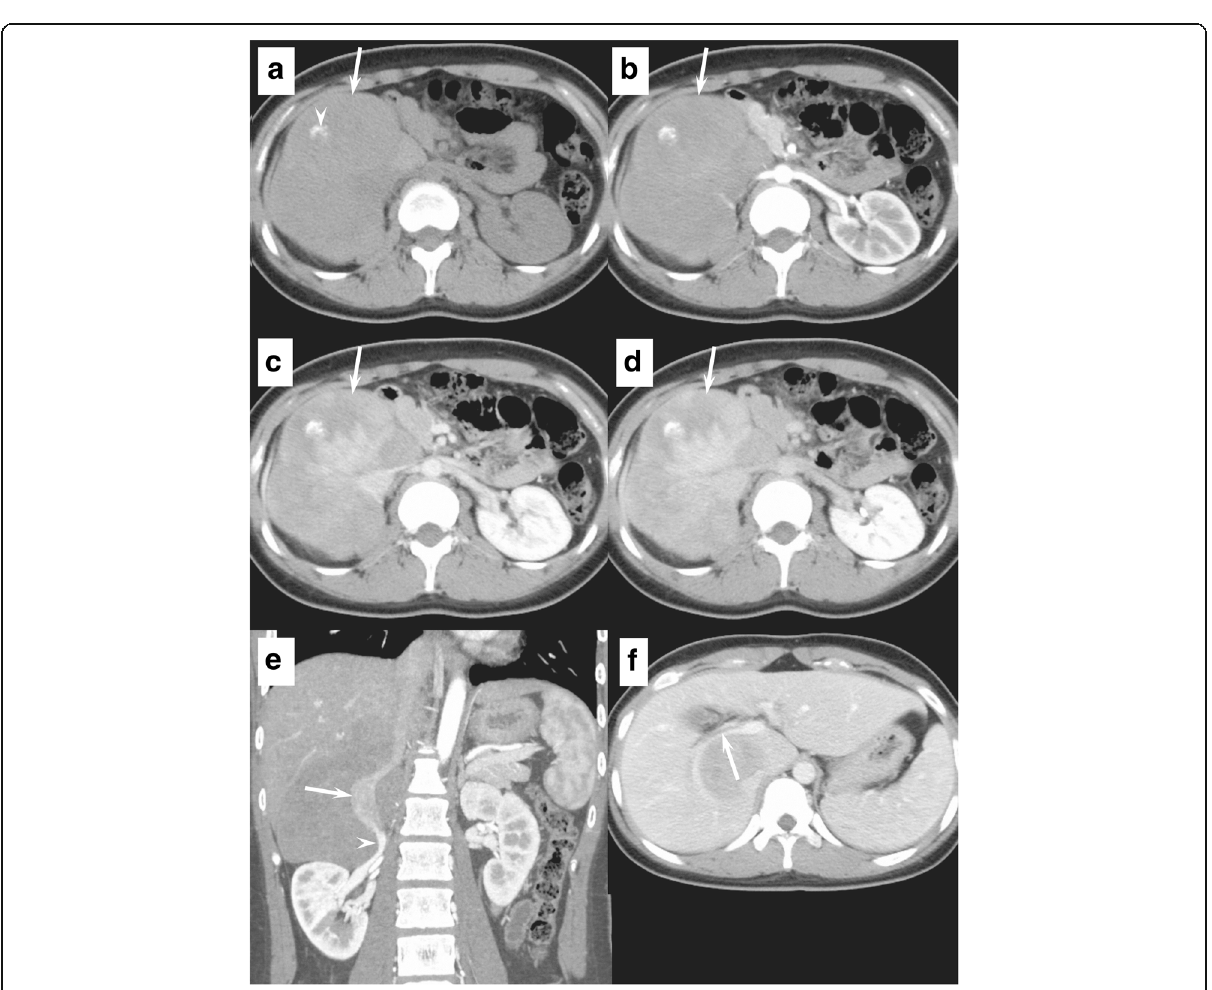
Fig. 1 Abdominal computed tomography. a Unenhanced CT image shows a well-demarcated, expansile, soft tissue lesion (arrow) with focal calcification (arrow head) in the right peritoneum. b – d Dynamic contrast-enhanced CT images show delayed enhancement (arrows). e Coronal reformatted contrast-enhanced CT image shows dilatation of the IVC lumen circumferentially surrounded by the lesion (arrow) and stenosis of the right renal vein (arrow head). f Contrast-enhanced CT image shows the compressed right Glisson capsule